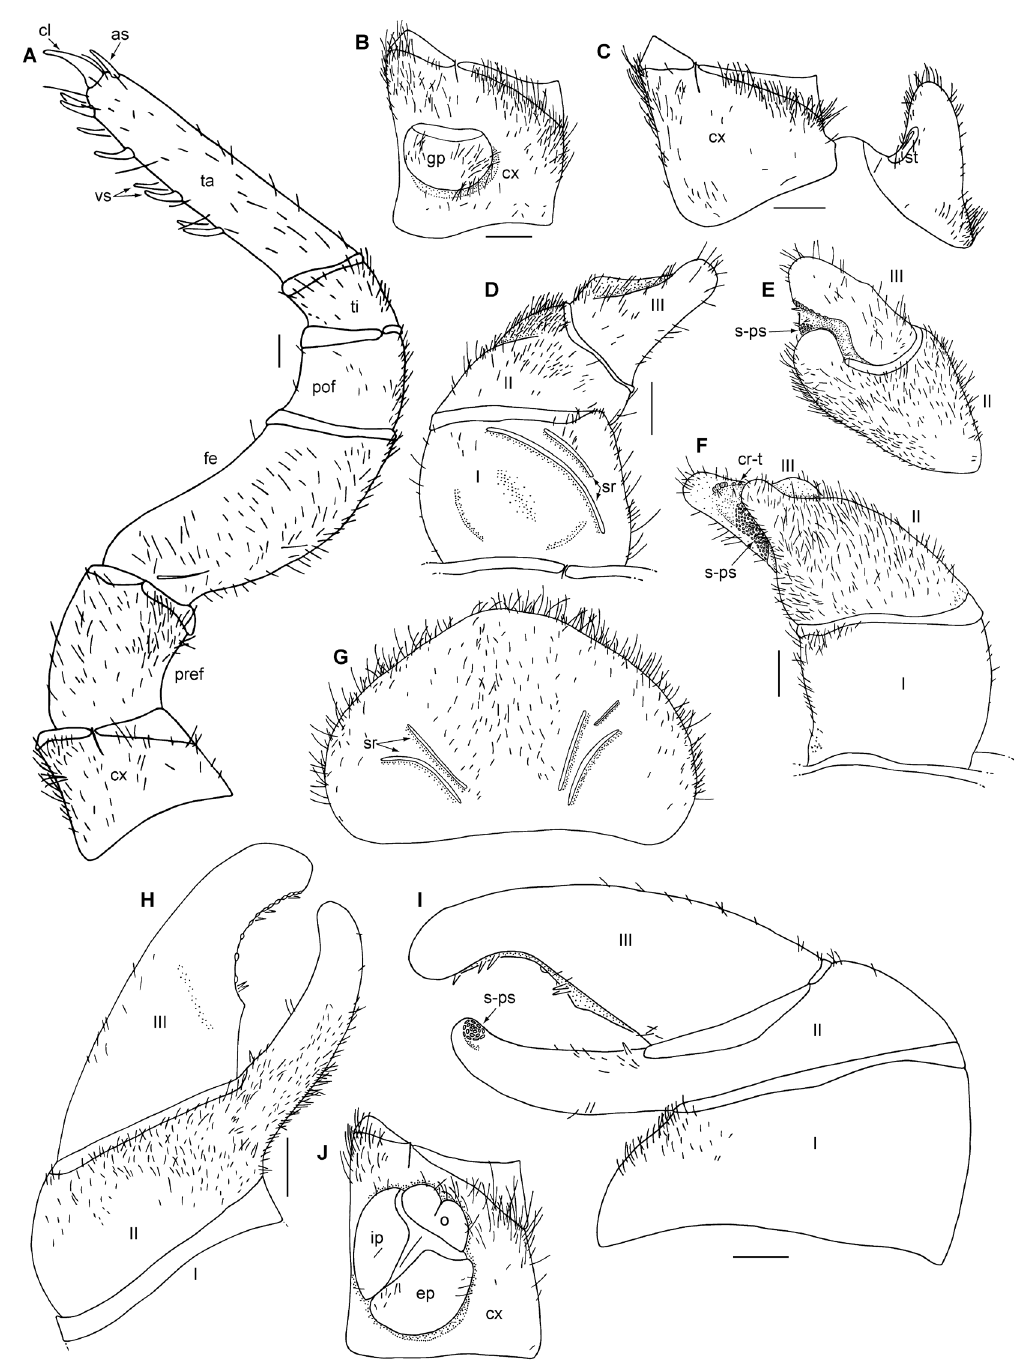
Fig. 7. Zoosphaerium ambatovaky sp. nov., holotype (CASENT 9068291). A . Left leg 9, posterior view. B . Left coxa 2 with gonopore, posterior view. C . Left coxa 1 with stigmatic plate, posterior view. D . Left anterior gonopod, anterior view. E . Left anterior gonopod, posterior view. F . Left anterior gonopod, lateral view. G . Left female coxa 2 with vulva, posterior view. H . Female subanal plate with washboard. I . Right posterior telopod, posterior view. J . Right posterior telopod, anterior view. Abbreviations: as = apical spine; cl = claw; cr-t = crenulated teeth; cx = coxa; ep = external plate; fe = femur; gp = gonopore; ip = inner plate; o = operculum; pof = postfemur; pref = prefemur; s-ps = sclerotized spots; sr = stridulation rib; st = stigmatic plate; ta = tarsus; ti = tibia; vs = ventral spines. Roman numerals indicate telopoditomeres. Scale bars = 1